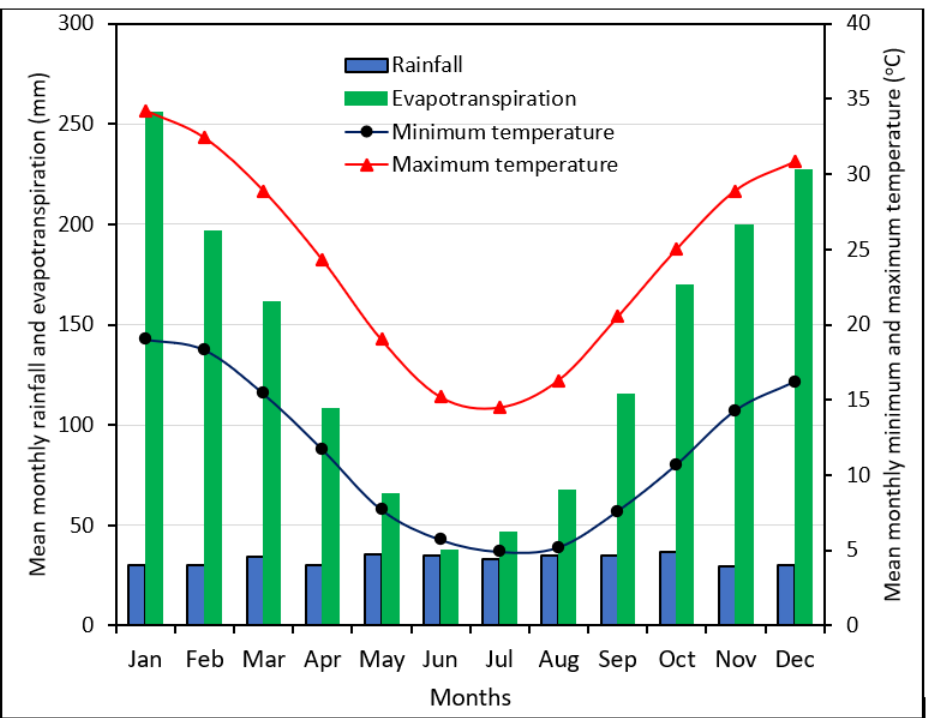
Figure 2. Mean monthly rainfall, temperature and evapotranspiration at Leeton station, Riverina region, NSW Australia (1989–2018).